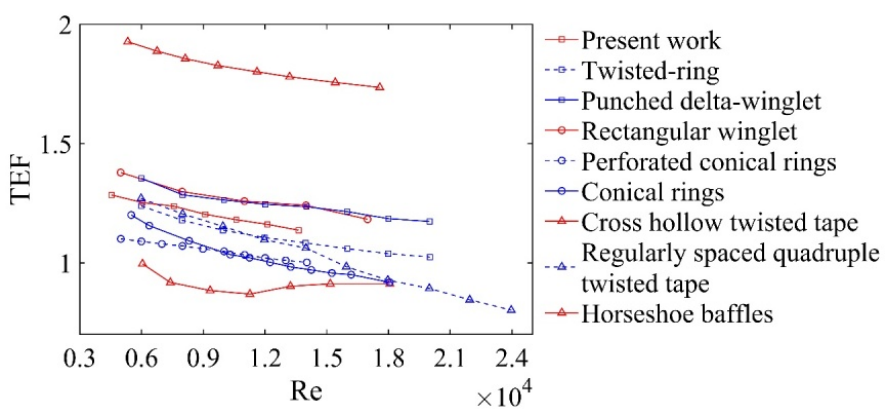
Figure 12. Comparisons of TEF between present work and previous works.